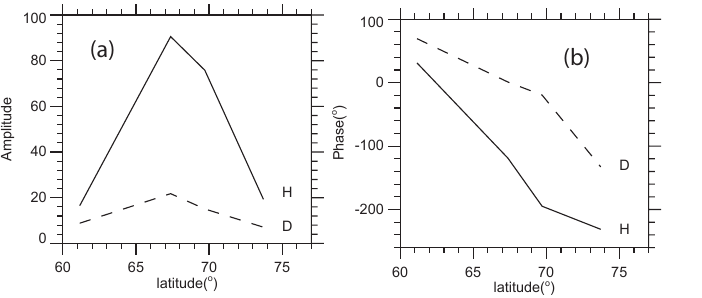
Fig. 11. The complex demodulation analysis of the 1.1-mHz wave from the CANOPUS Churchill line. The FLR characteristic is verified by the amplitude maximum between GILL and FCHU and the 180 ◦ latitudinal (CGM latitude is used here) phase change in the